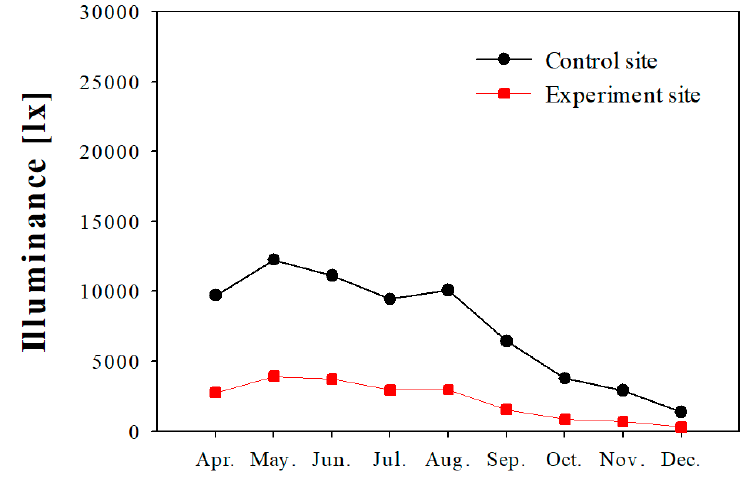
Figure 18. Illuminance comparison.